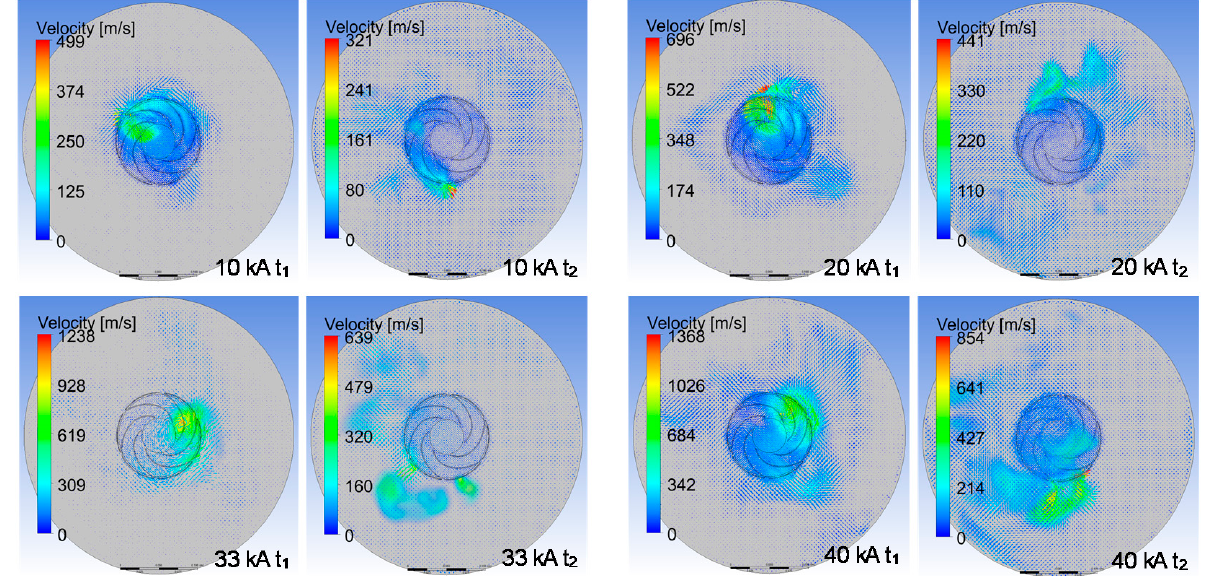
Figure 11. A comparison of the velocity vector under different current levels with a range between 10 kA and 40 kA. t 1 and t 2 respectively represents the time of peak current and 28 μ